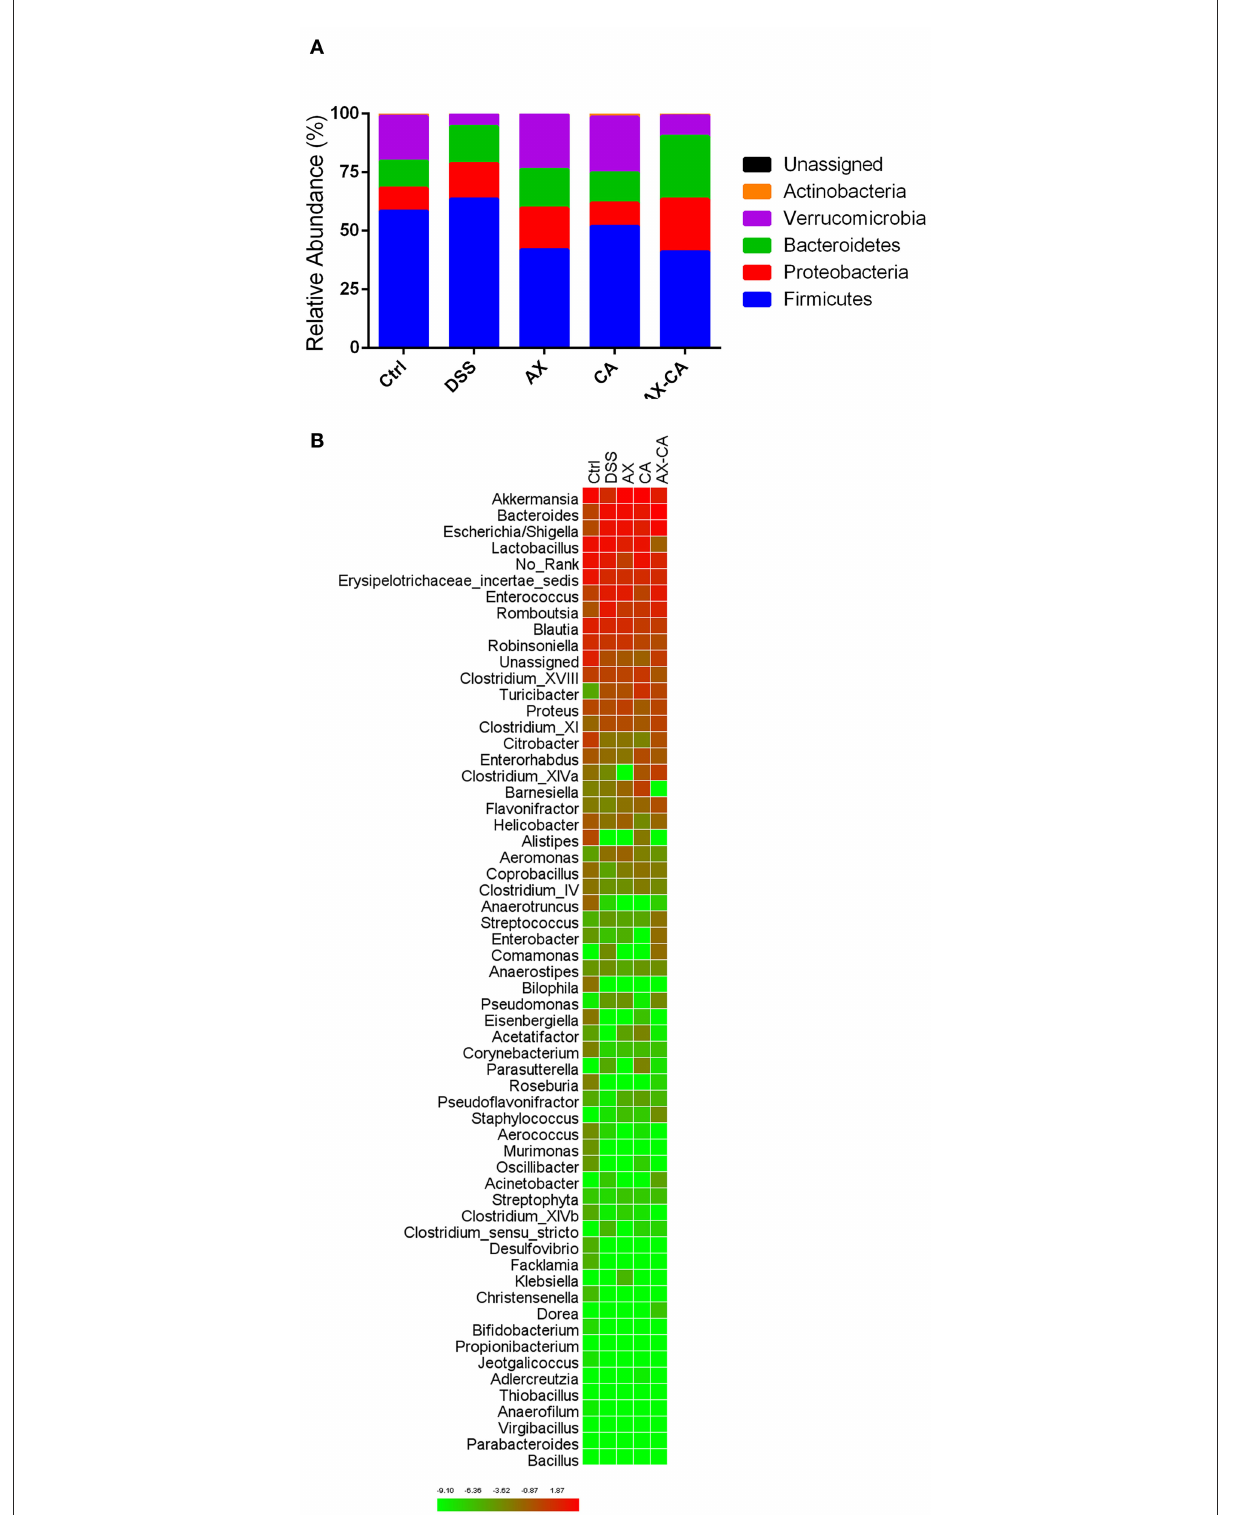
FIGURE5 Intestinal microbial composition of the mice in each group, at the phylum (A) and genus (B)